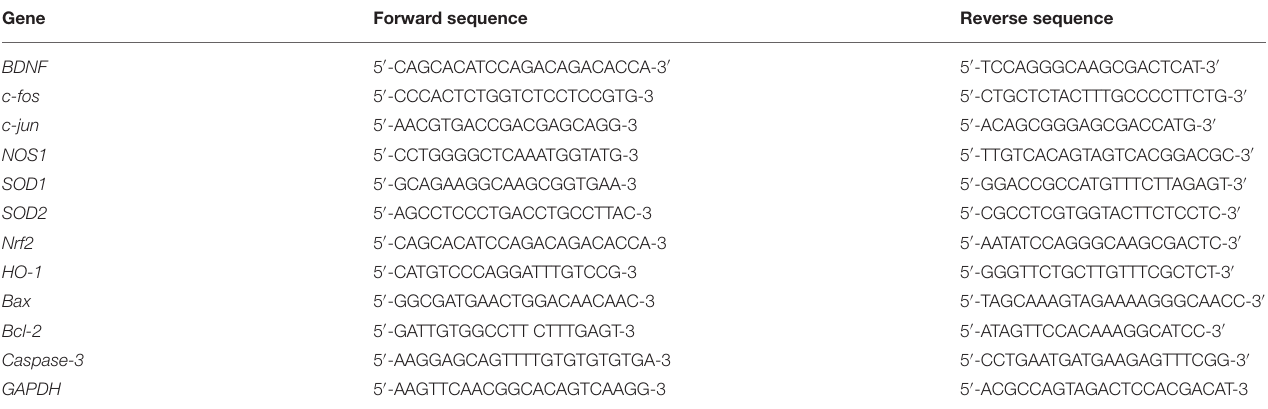
TABLE 1 | Sequences of primers.